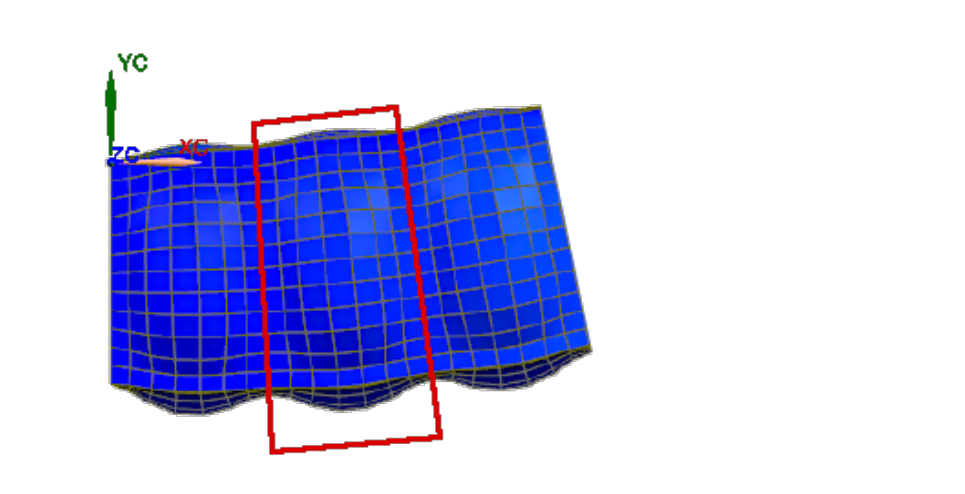
Figure 5. Three unit FE model of a soft bending actuator. The red wedge indicates the centre unit used as input for the reduced-order model.